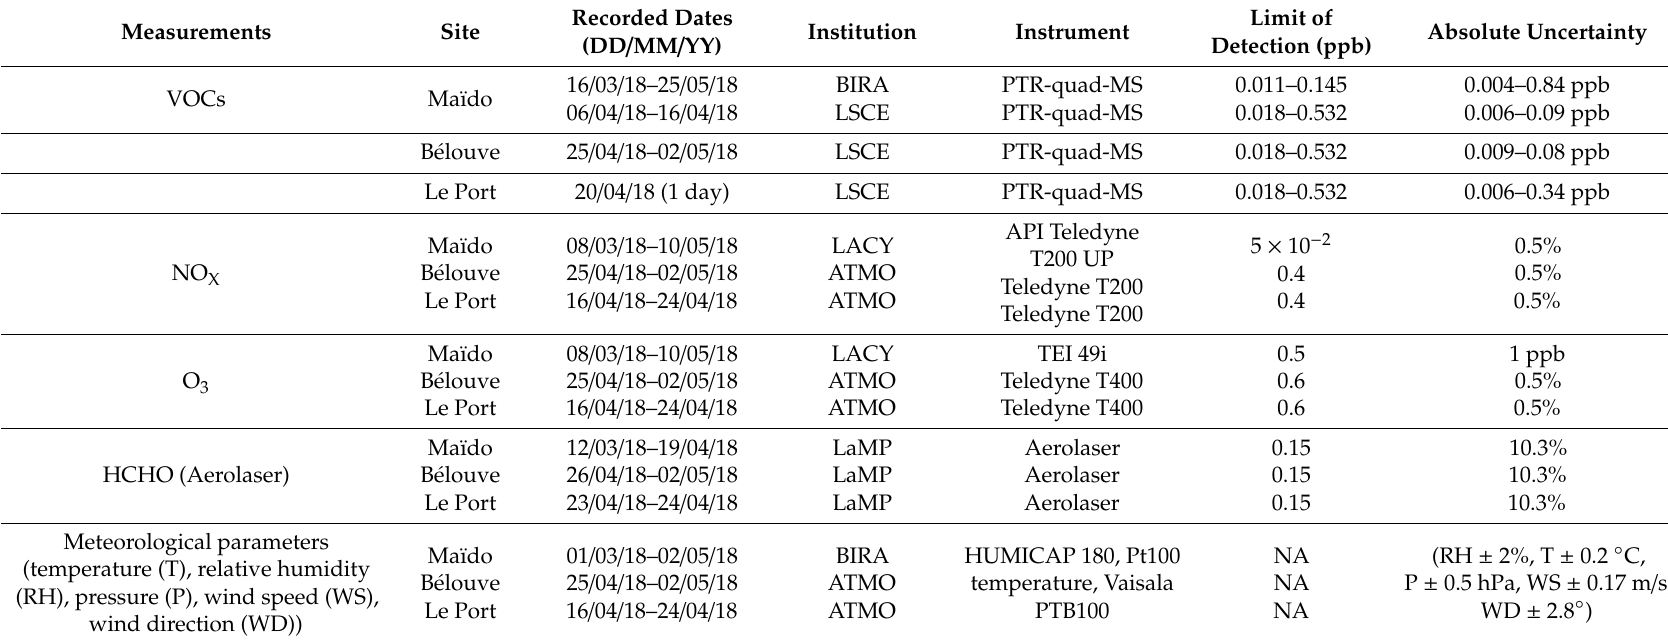
Table 1. Online instrumentation during Oxygenated Compounds in the Tropical Atmosphere: Variability and Exchanges (OCTAVE) campaign. BIRA: Royal